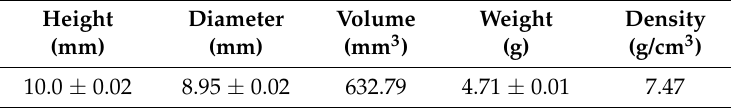
Table 5. Density of turned cylinders with 100% infill ( n = 3).